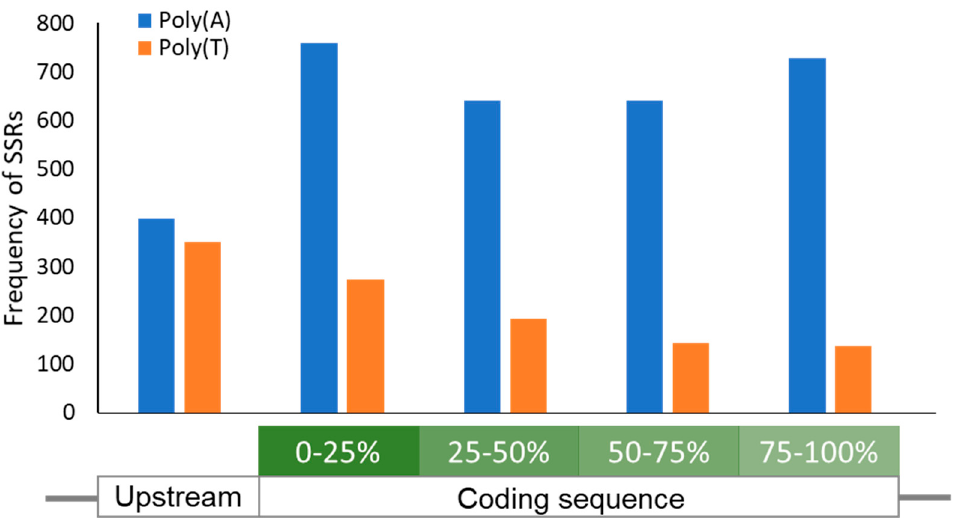
Figure 3. Location distribution of homonucleotide SSRs in S. aureus . A graph showing the location-dependent frequency of Poly(A)/(T) SSRs ≥ 6 nucleotides in length. A 100-nucleotide region upstream of all Open Reading Frames (ORFs) was also screened for SSRs. While Poly(T) SSRs are relatively enriched towards the 5’ of the ORF as reported [54], Poly(A) SSRs ≥ 6 nucleotides in length were found to be evenly distributed across the ORF. In contrast, the abundance of both SSR types is evenly matched in the region immediately upstream of the ORF. Supplementary Materials: The following are available online at www.mdpi.com/xxx/s1, Figure S1: Homonucleotide SSRs in S. aureus MW2.